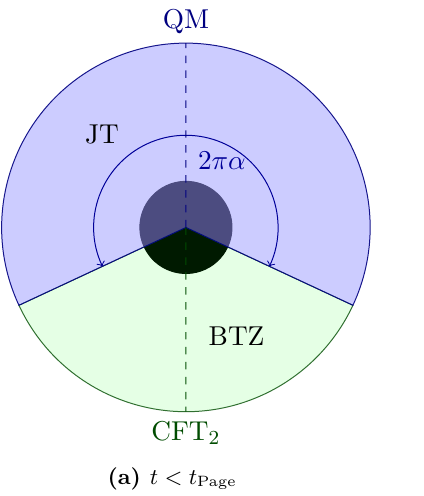
Figure 2. We have done a partial reduction over the angle 2 πα . The value of α determines if the black hole is before (a) or after (b) the Page